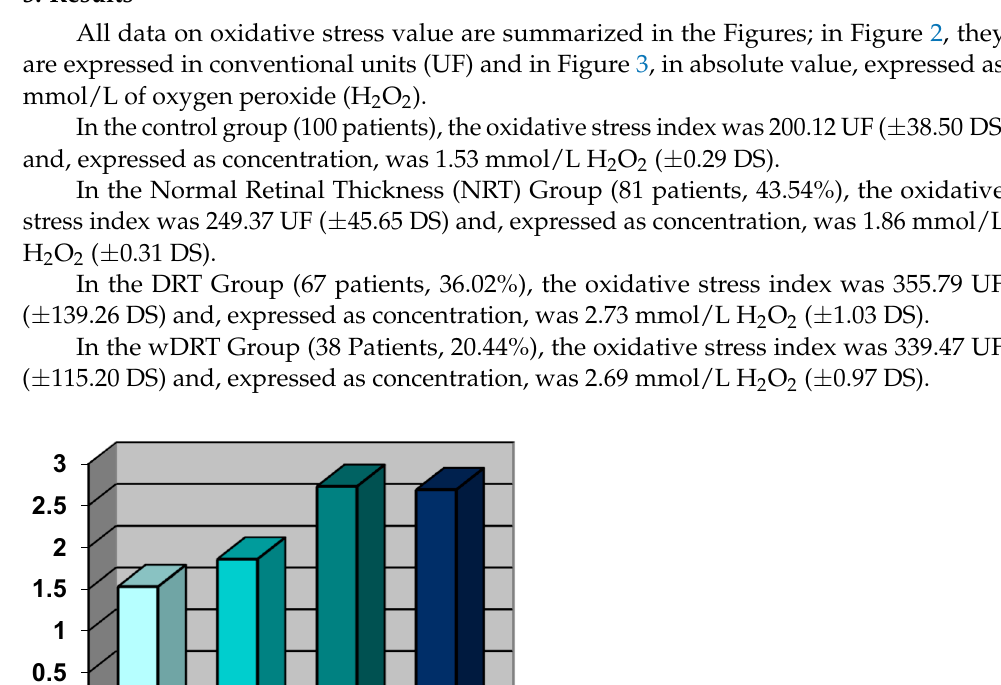
00.511.522.53 Figure 2. The value of the ROS species in all four groups of RP patients selected on the basis of OCT scans; data were expressed in free oxygen radical test (Fort) units. The value in the Normal Group was chosen as the reference. Figure 3. The value of the ROS species in all four groups of RP patients selected on the basis of OCT scans; data were expressed in mmol/L of the value of H 2 O2. The value in the Normal Group was chosen as the reference. Free oxygen radical test levels were significantly increased almost twice in patients with retinitis pigmentosa showing cystoid macular oedema and significantly increased over the control group. p < 0.001). No statistical difference ( p = 0.153) was found between the two groups with regional or diffuse macular involvement. 4. Discussion Our findings suggest that oxidative stress may speed cone photoreceptor morphological damage (CMT) as previously suggested by Campochiaro [13,14]. As reported in the literature, ROS promotes damage of the blood–retinal barrier; modulating the production of vasoactive factors, ROS modifies retinal blood flow and also determines upregulation of the retinal expression of VEGF and other adhesion molecules such as ICAM-1 [15–19]. This cascade of molecular events causes leakage of fluids into the surrounding tissue, which initially accumulate within Müller cells. These fluids are clearly evident in OCT scans in the inner layers of the retina; moreover, the morphological changes precede the onset of the clinical features of CSME, are measurable by CMT, and may be defined as the DRT pattern. [3,4,8,9,15,17,18]. In experimental models of RP (mainly mice), the death of rod photoreceptors activates mechanisms that cause progressive oxidative damage directly to cones and, subsequently, follow the main channel of Muller’s architecture to other structural and glial cells of the inner retina [1–4,13,15]. Several studies in the literature pointed out the involvement of excessively high ROS concentrations and cellular damage in animals and in humans; in their eyes, high levels